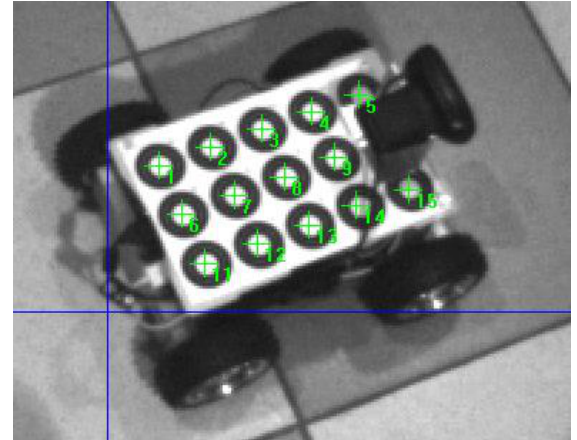
Figure 7. The images of UAV during the flight acquired by the motion capture system.